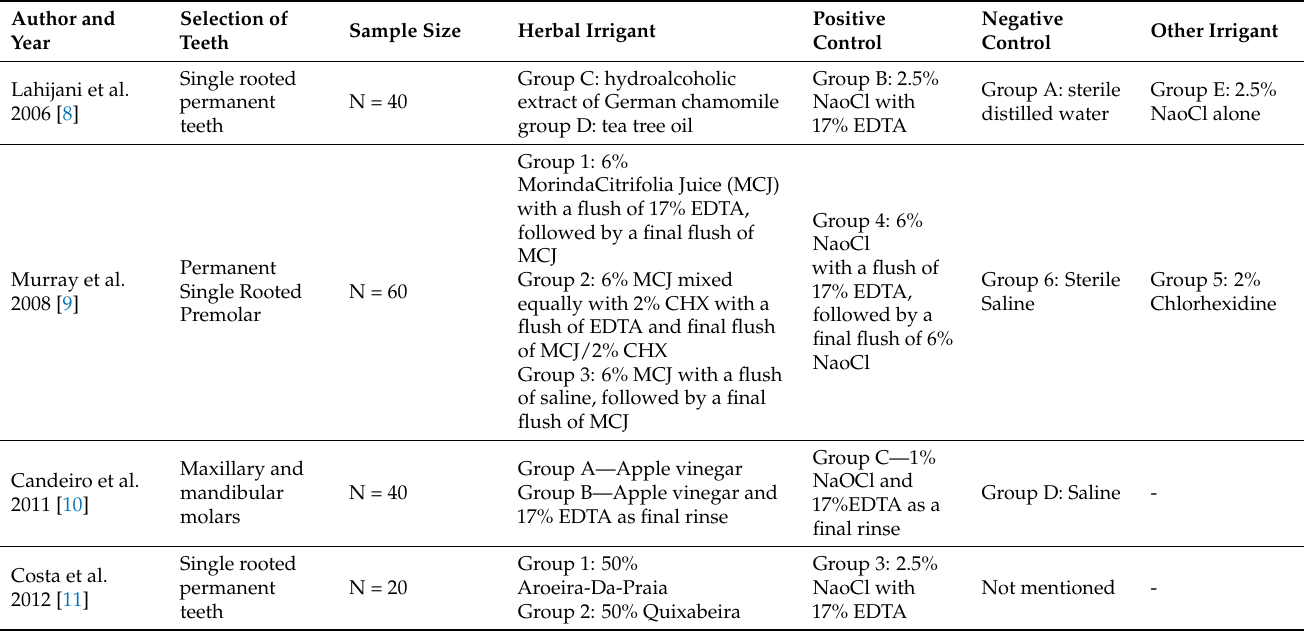
Table 3. Smear layer